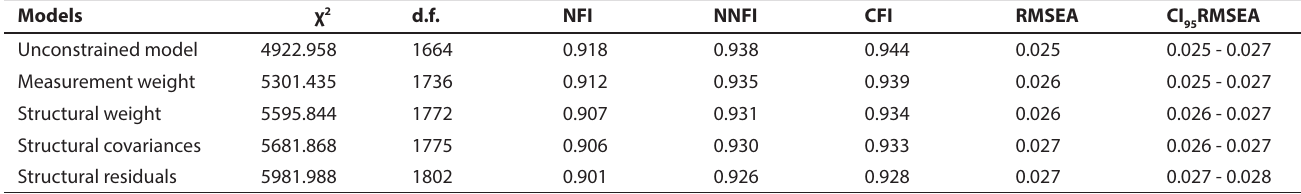
criteria adopted (Table 5). Subsequently, to test the invariance of the measurement weight, the factor loadings were constrained to be invariant across the four samples. Invariance of the factor loadings is considered the minimum acceptable criterion for measurement invariance (Byrne, 2010). The difference of the incremental fit indices (ΔCFI; 0.944 - 0.939 = 0.005) did not exceed the value of 0.01, indicating the existence of the invariance of measurement weight. In the subsequent nested model in which the invariance of the structural weights was tested beyond the constraints of factor loadings, the structural paths were constrained to be equal. The result of ΔCFI also indicated the invariance of structural weights. Finally, the ΔCFI values of the models testing the invariance of structural covariances and structural residuals (error variance associated with dependent factors) showed the equality of these parameters across the four nations. TABLE 5 Goodness-of-Fit statistics and Model Comparisons for Multisample Structural Equation Models